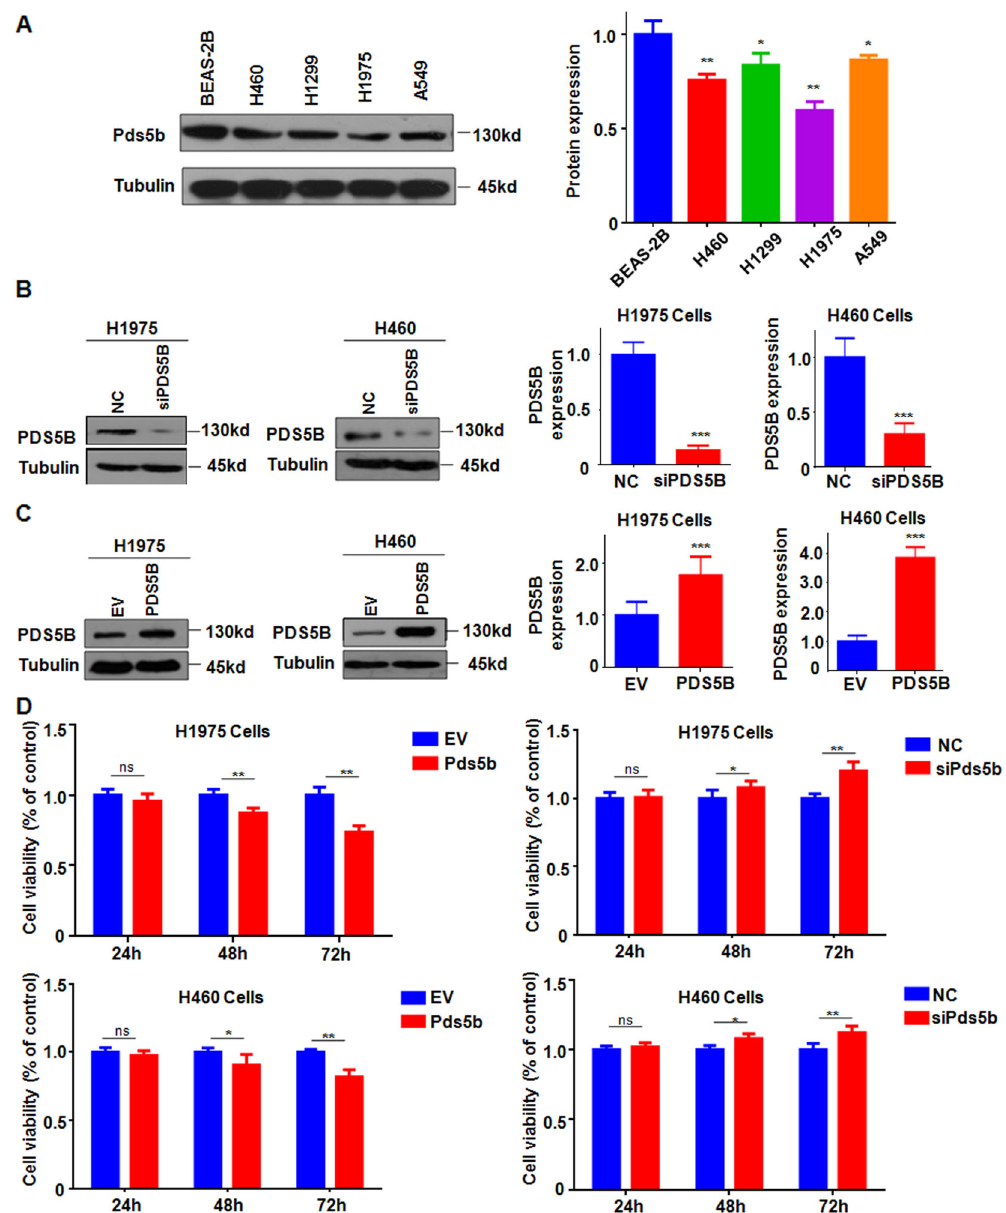
Fig. 1 PDS5B overexpression represses cell viability. A Left panel: the expression of PDS5B was measured in the panel of lung cancer cells and the normal lung epithelial BEAS-2B cells. Right panel: Quantitative results of PDS5B expression. ** P < 0.01 vs BEAS-2B cells. B Left panel: The expression of PDS5B was decreased in NSCLC cells after PDS5B siRNA transfection. Right panel: quantitative results of PDS5B expression. *** P < 0.001 vs NC group. NC nonspeci fi c control siRNA, siPDS5B PDS5B siRNA. NC group is the control group. C Left panel: the expression of PDS5B was increased in NSCLC cells after PDS5B cDNA transfection. Right panel: quantitative results of PDS5B expression. *** P < 0.001 vs EV group. EV empty vector, PDS5B PDS5B cDNA. EV group is the control group. D Effects of PDS5B modulation on cell viability at different times in NSCLC cells were examined by MTT assays. ** P < 0.01 vs control group. NC nonspeci fi c control siRNA, siPDS5B PDS5B siRNA. EV empty vector, PDS5B PDS5B cDNA. All data are representative of three independent experiments. Data are shown as mean ± SD from experiments in